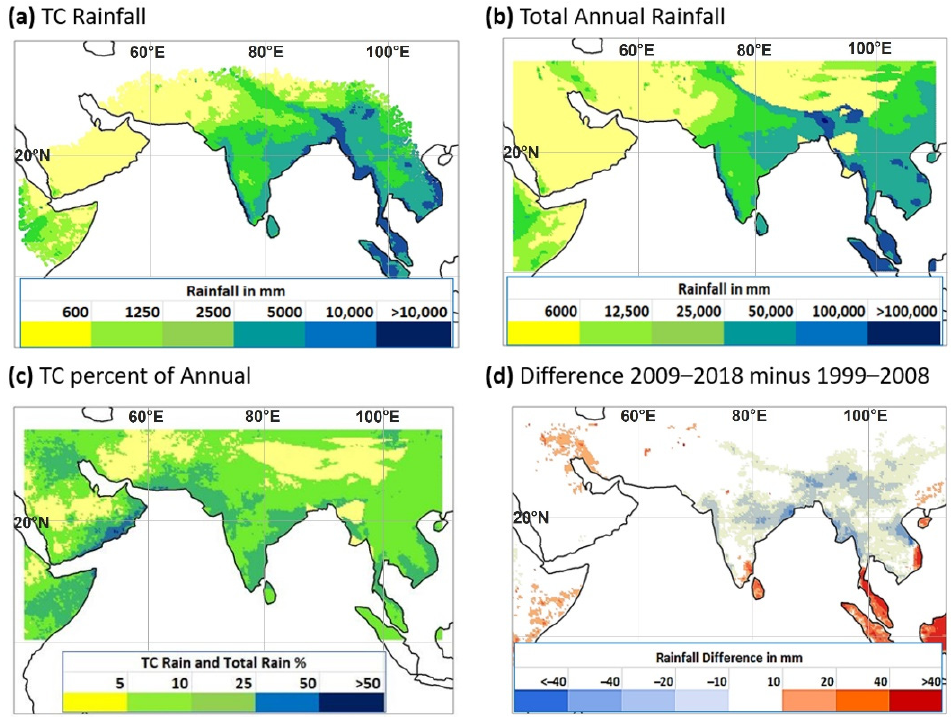
Figure 11. Extent of over land rainfall (mm) for the 20 years from 1999 to 2018 for ( a ) TC rainfall; ( b ) Total annual rainfall; ( c ) percent TC annual rainfall; and ( d ) the difference between the two 10-year periods 1999–2008 and 2009–2018.